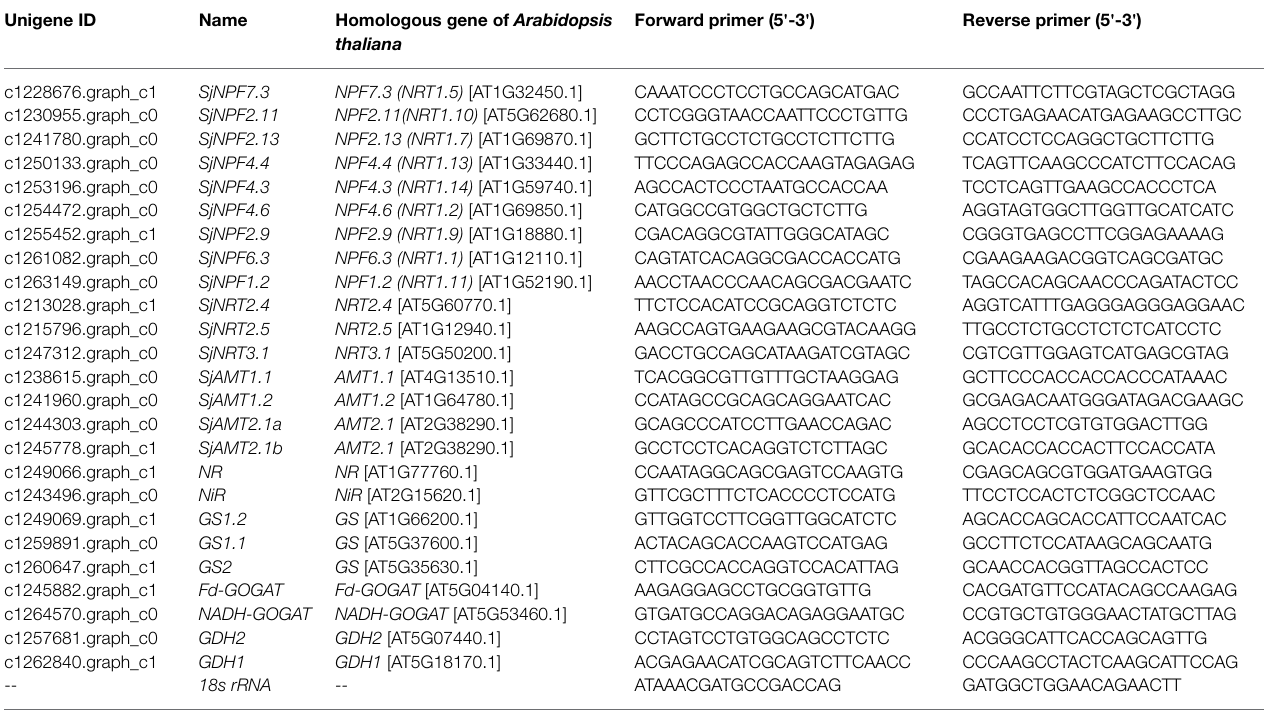
TABLE 1 | The information of genes related to nitrogen uptake and metabolism in Sophora japonica . Unigene